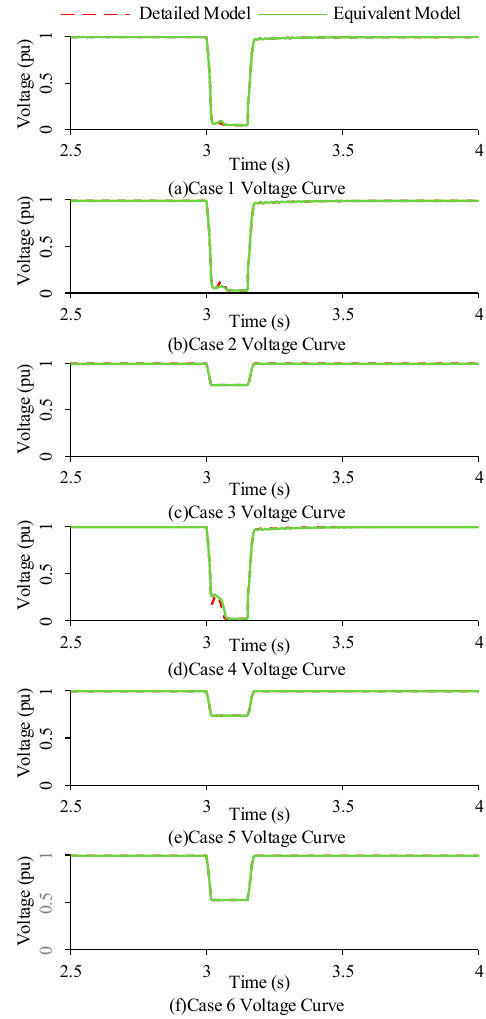
Figure 10. Voltage curves in PCC of different models.